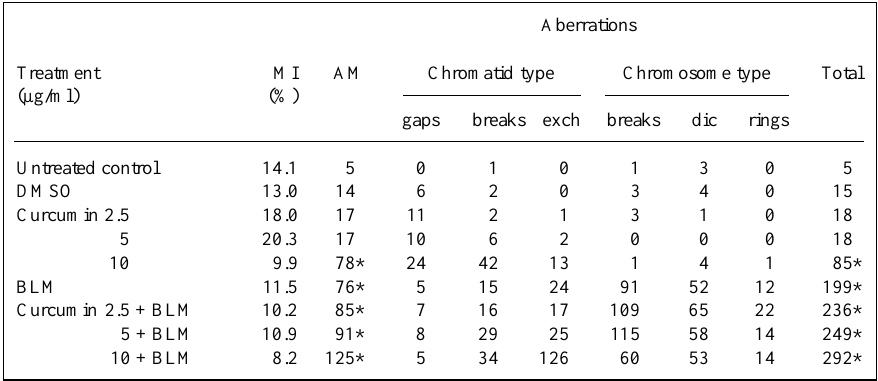
For symbols and abbreviations see Table